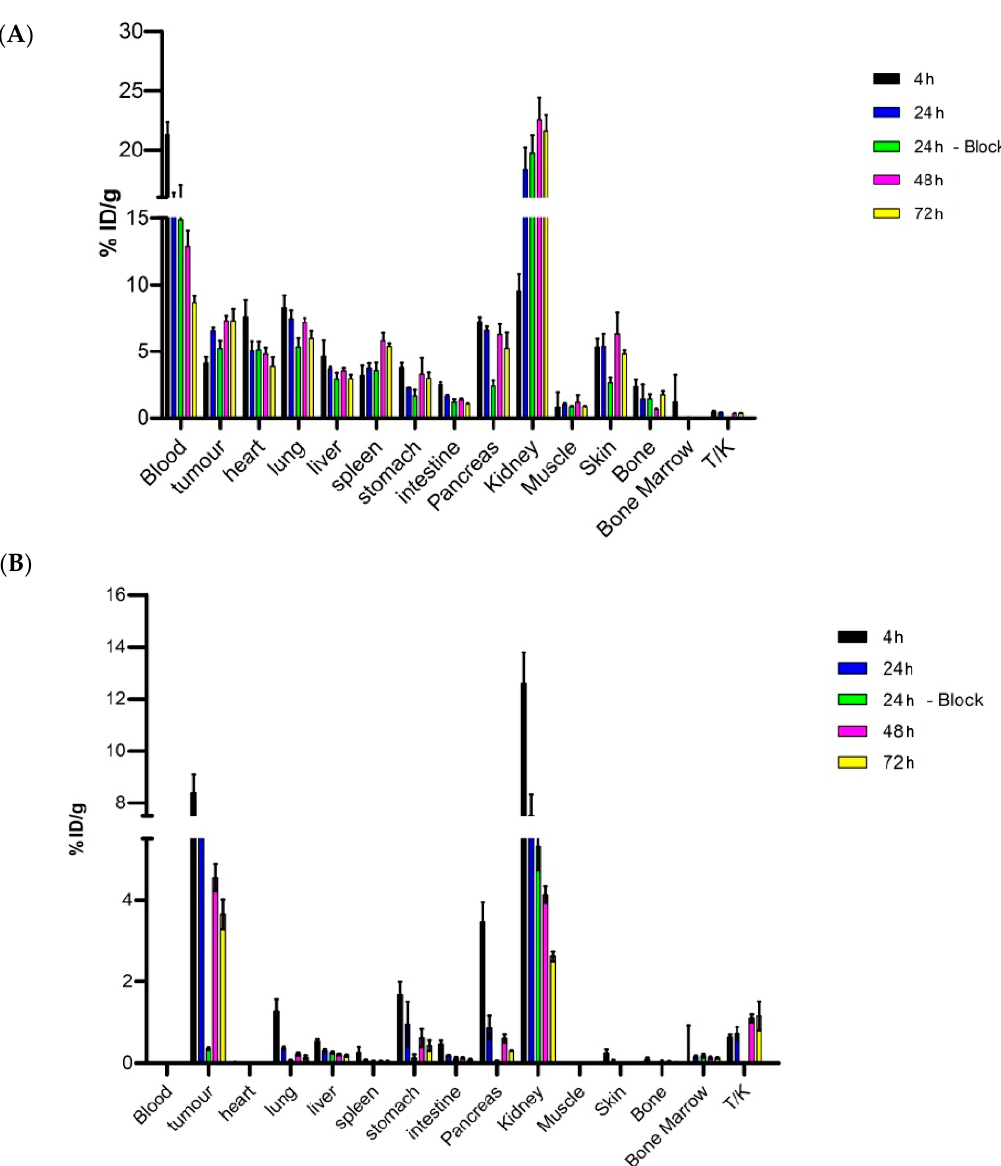
Figure 3. Ex vivo biodistribution analysis of ( A ) [ 177 Lu]Lu- 8a (5 MBq/0.5 nmol) and ( B ) [ 177 Lu]Lu- JR11 (5 MBq/0.5 nmol) at 4, 24, 48, and 72 h post-injection ( n = 4 mice/group). Data represented as percentage of injected dose per gram of tissue (% ID/g).